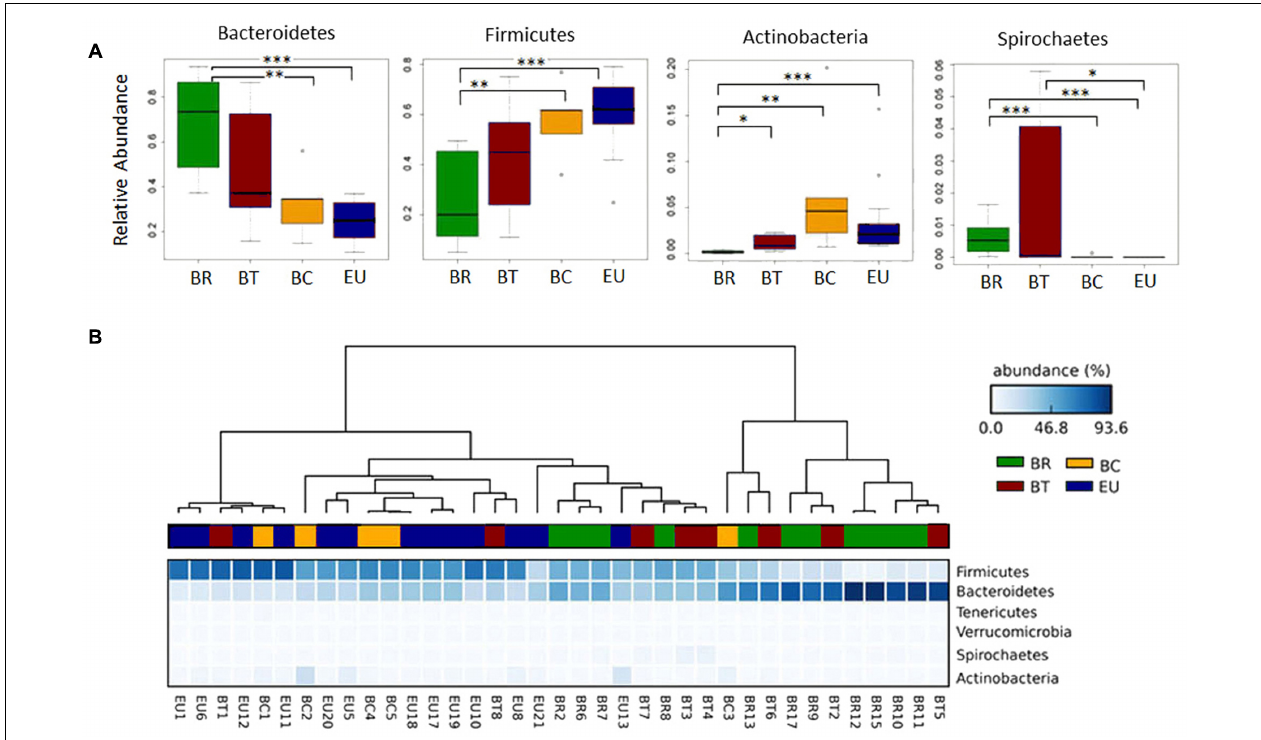
FIGURE 4 | Clustering of African and European populations based on microbiota composition. (A) Box plot of relative abundances of the statistically significant different major phyla in African and European populations (Wilcoxon rank sum test; ∗ p -value < 0.05, ∗∗ p -value < 0.01, ∗∗∗ p -value < 0.001). (B) Heatmap plot indicating the sequence abundances (percentage; blue-scale squares) assigned at each phylum in each sample. Dendrograms, obtained with Average Neighbor UPGMA method, are used to cluster each fecal sample of the children populations (horizontal) based on phyla abundances. Each sample, belonging to respective group, is represented by a different color: green = BR, brown = BT, yellow = BC, and blue =